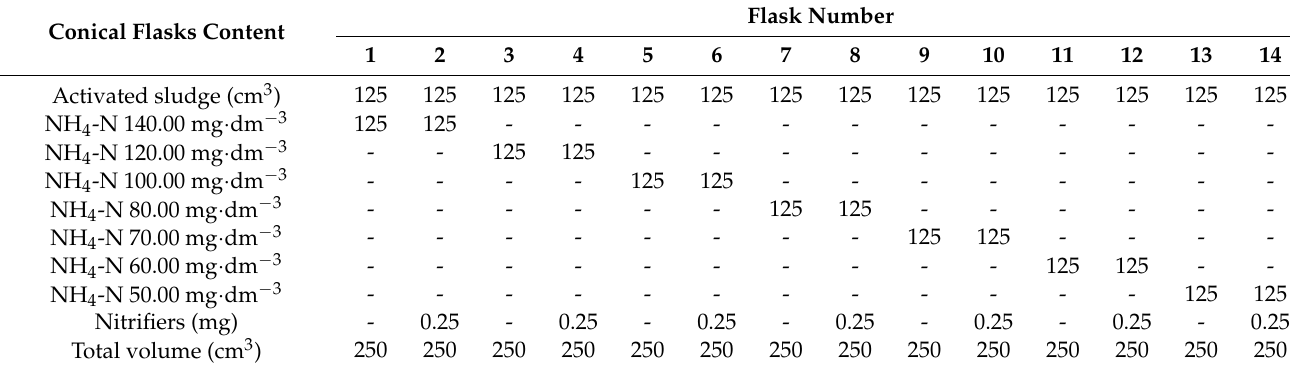
Table 2. Diagram of a static